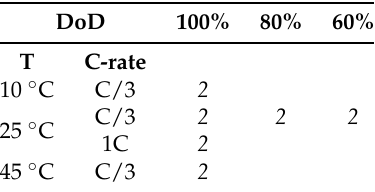
Table 3. Cycle aging test campaign.